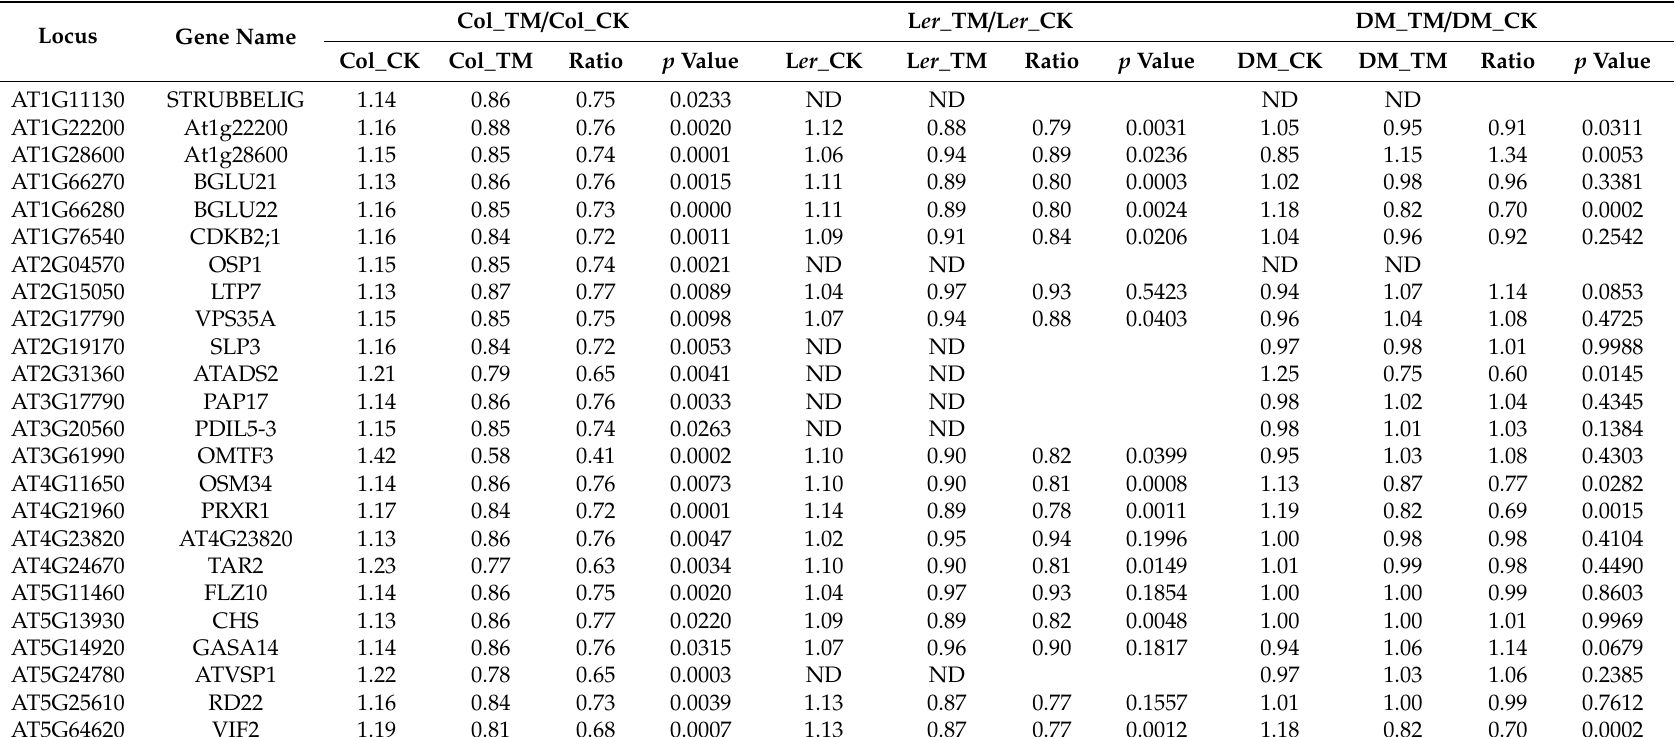
Table 5. Di ff erential downregulation of proteins by ER stress in Col, L er, and DM